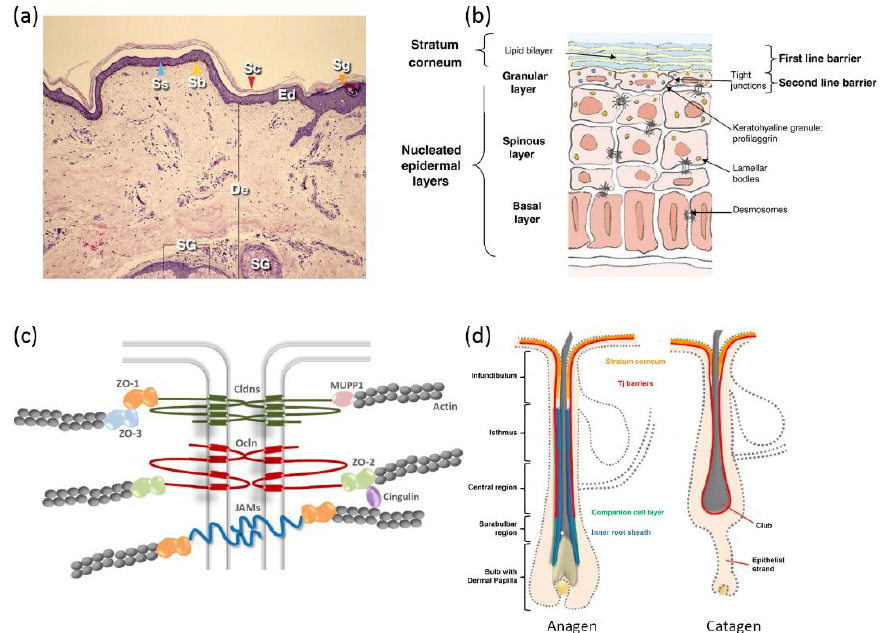
Figure 1. Schematic illustrations of skin: ( a ) histological cross-section of the skin (Ed—epidermis; Sc—stratum corneum; De—dermis; Sg—stratum granulosum; Ss—stratum spinosum; Sb—stratum basale; SG—sebaceous gland) (reproduced with permission from Arda et al., Clinics in Dermatology, adapted with permission from Ref. [49]. Copyright 2014 Elsevier); ( b ) epidermis structure (reproduced with permission from Baroni et al., Clinics in Dermatology; adapted with permission from Ref. [34]. Copyright 2012 Elsevier); ( c ) protein complexes of tight junctions (reproduced with permission from Basler et al., Journal of Controlled Release; adapted with permission from Ref. [46]. Copyright 2016 Elsevier); and ( d ) hair follicle structure of anagen phase and catagen phase (Reproduced with permission from Gorzelanny et al., Pharmaceutics; adapted with permission from Ref. [36]. Copyright 2020